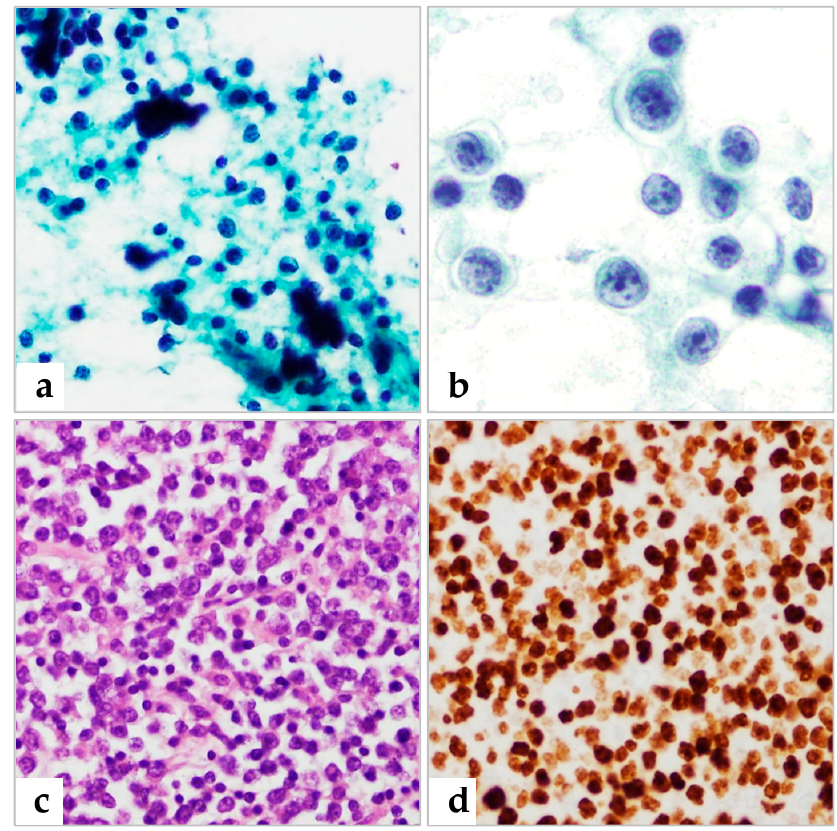
Figure 2. A patient erroneously diagnosed with reactive hyperplasia by FNAC was histologically proven to have diffuse large B cell lymphoma (DLBCL). ( a , b ) Pap smear showing a mixture of large and smaller lymphoid cells ( a ) and atypical lymphoid large cells with vesicular chromatin and prominent nucleoli ( b ). ( c ) Histologic section of DLBCL (H&E). ( d ) Ki-67(90%) in IHC. ( a ) 400 × ; ( b ) 1000 × ; ( c , d ) 400 × magnification.